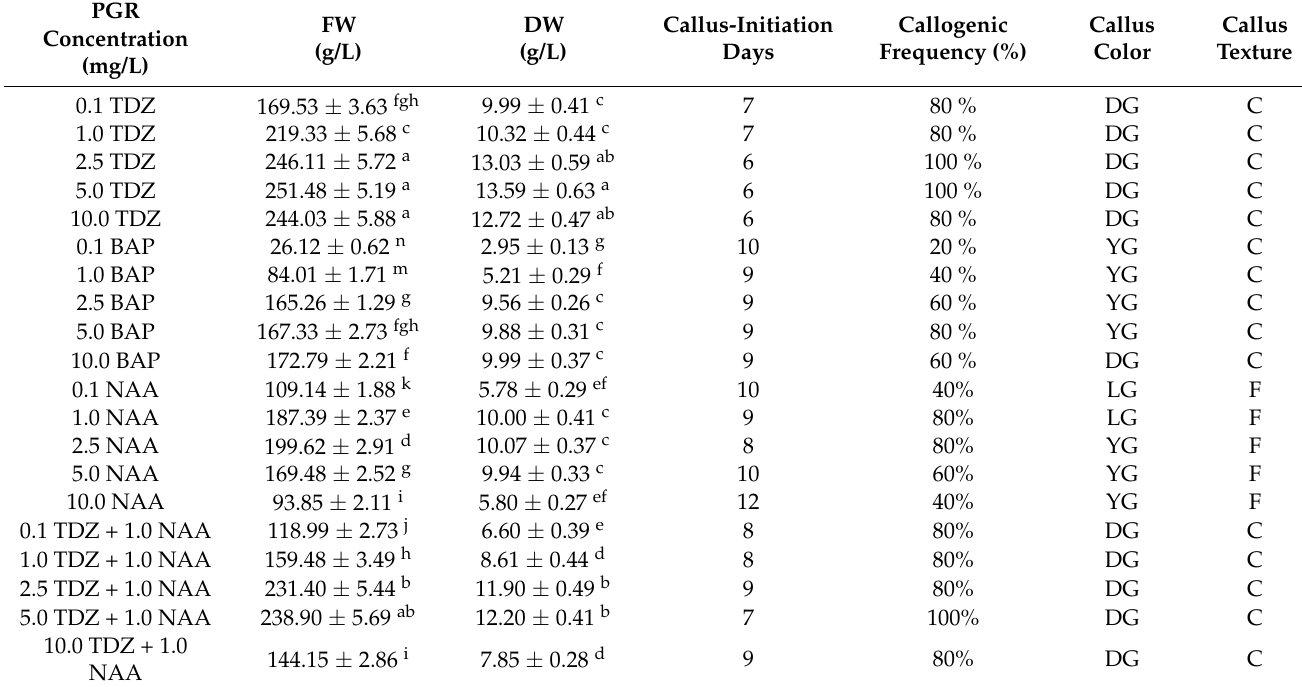
Table 1. Physiological parameters with FW and DW analyses of callus